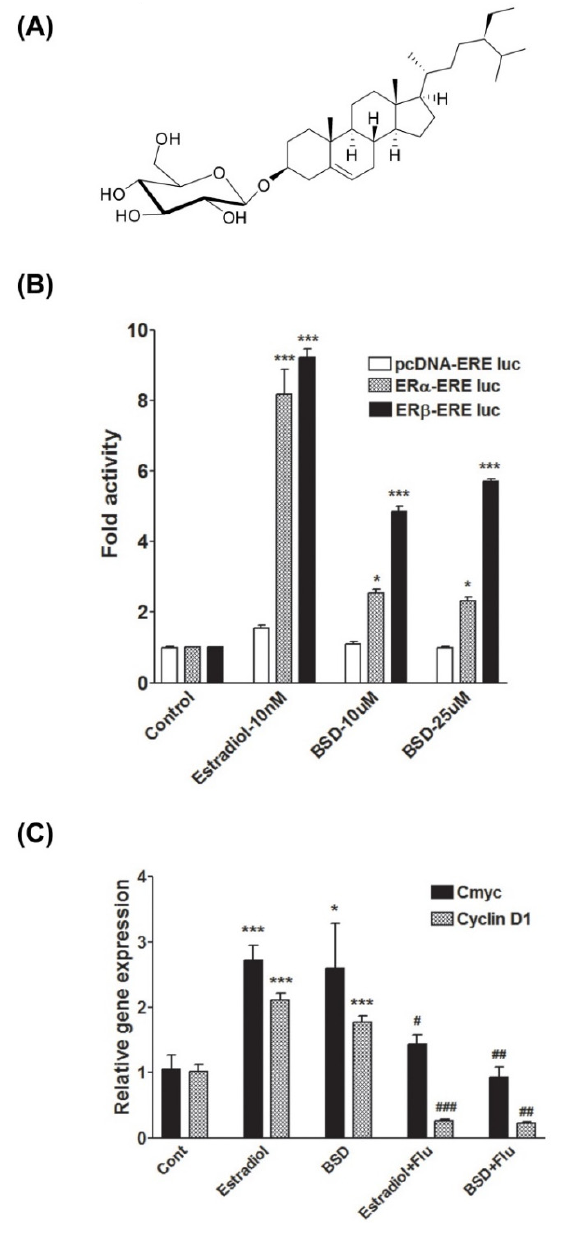
Figure 1. ( A ) Chemical structure of β -sitosterol-D-glucopyranoside (BSD) isolated from the fruits of C. sempervirens ; ( B ) estrogenic activity of BSD in ER α / β -ERE luc expression system in HEK-293T cells. Cells were transiently transfected with Estrogen response element-luc reporter (ERE-Luc) and ER α / β containing plasmids and incubated with indicated concentrations of BSD or Estradiol. Cells were lysed, and relative luciferase activity was determined. Results are expressed as fold over control. Results shown are mean ± SE of three independent experiments. * p <0.05, *** p <0.001 relative to respective control condition; ( C ) effect of BSD (10 µM)on expression of ER responsive genes in MCF-7 cells. Cells were treated as indicated for 24h and mRNA expression level of C-myc and cyclin D1 was determined by quantitative real-time PCR. Results are expressed as fold change over control, n =4. * p <0.05, *** p <0.001 relative to control, # p <0.05, ## p <0.01,### p <0.001 relative to respective without a Fulvestrant treated condition.